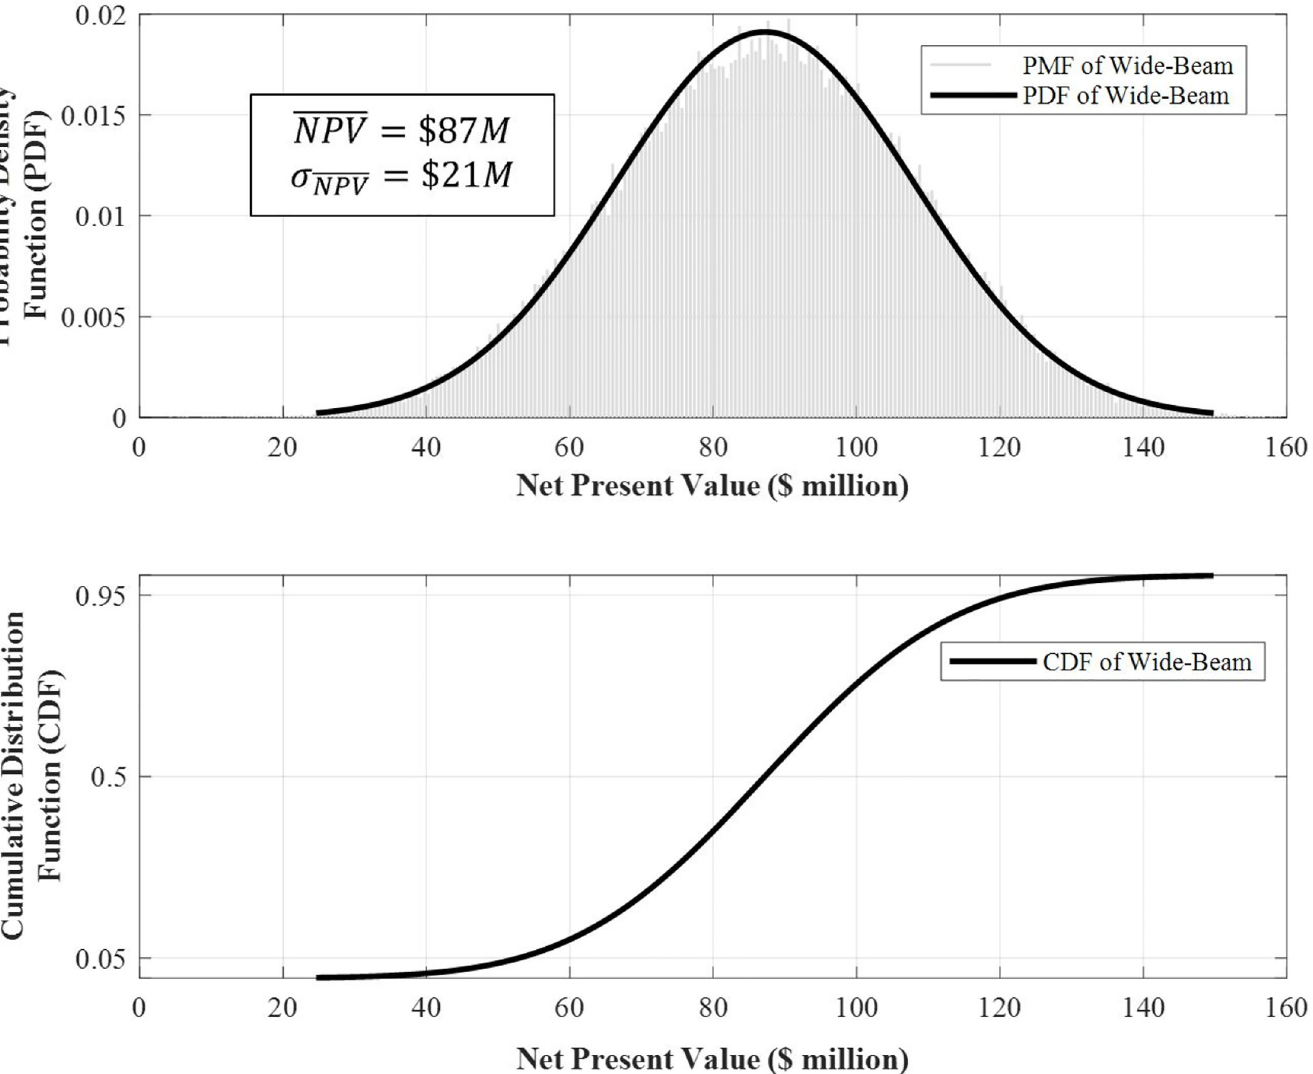
Fig 3. Probability density function (upper panel) and cumulative distribution function (lower panel) of the NPV of a 60-equivalent-transponder wide-beam communication satellite after a design life of 15 years on-orbit.